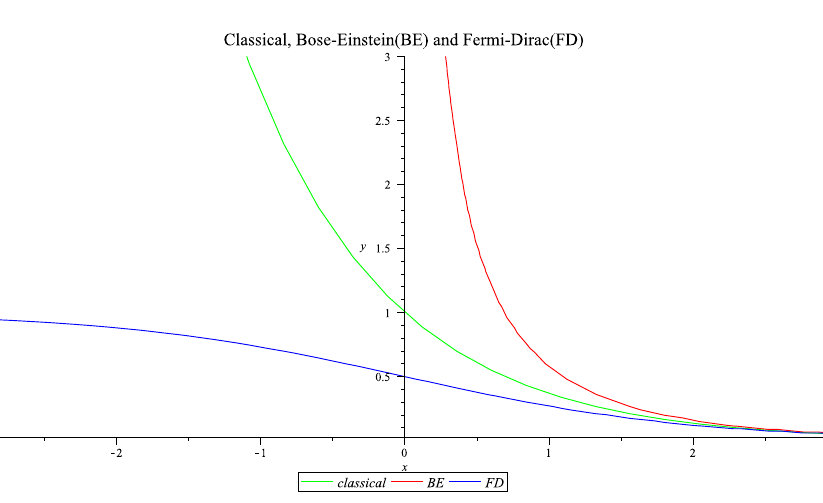
Figure 1. Comparison of Classic, BE and FD